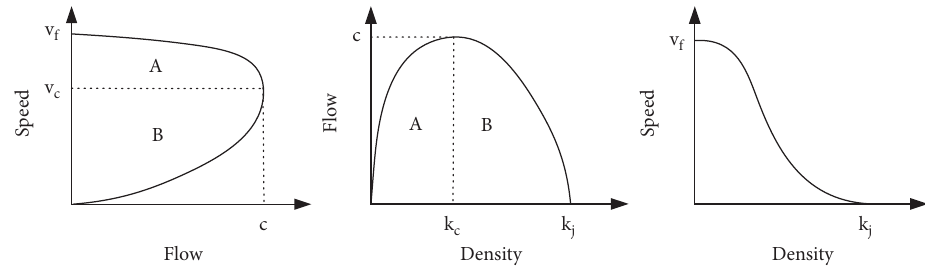
Figure 2: Te curve of speed-fow, fow-density, and speed-density relationships.